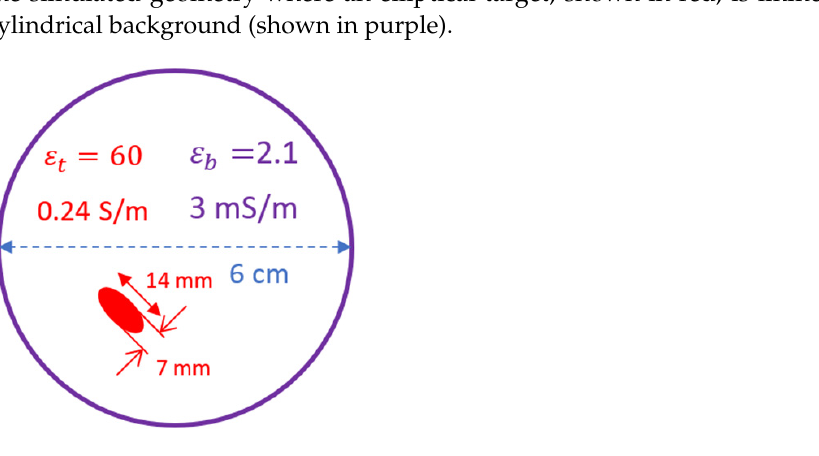
Figure 7. Geometric parameters and electrical properties of the simulated